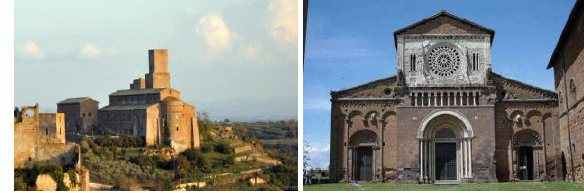
Figure 3: A view of the Civita Hill (left) and the main facade of the Basilica di San Pietro (right).